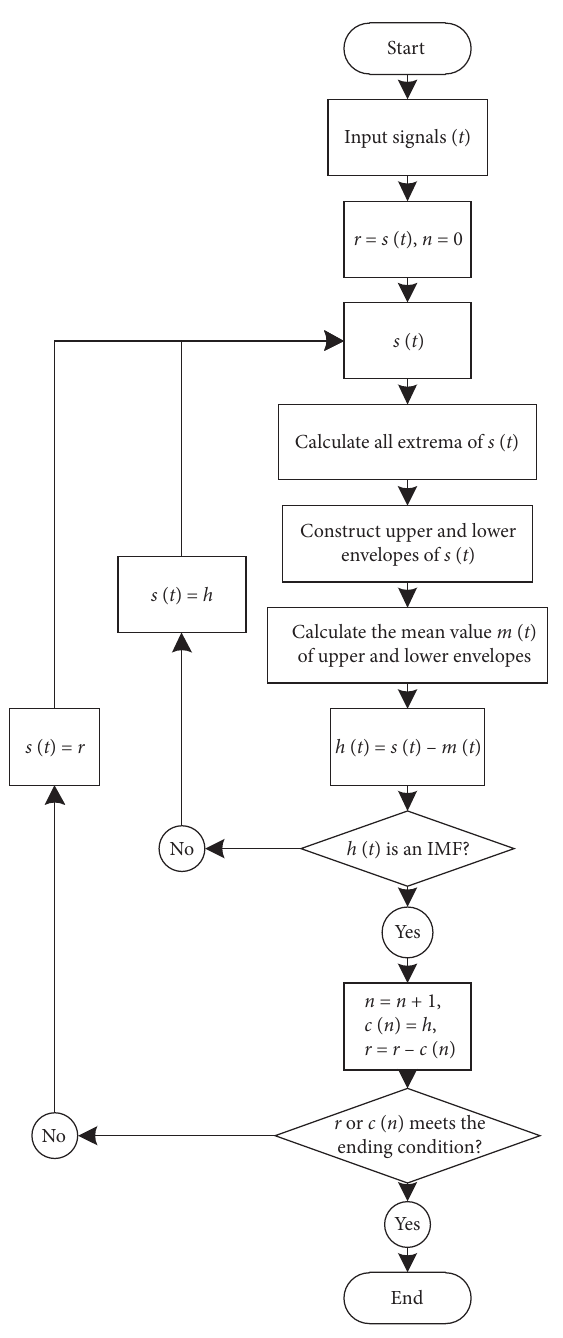
Figure 10: The flow chart of EMD method after EMD decom- position of signal s ( t ) , a remainder r , and I IMF